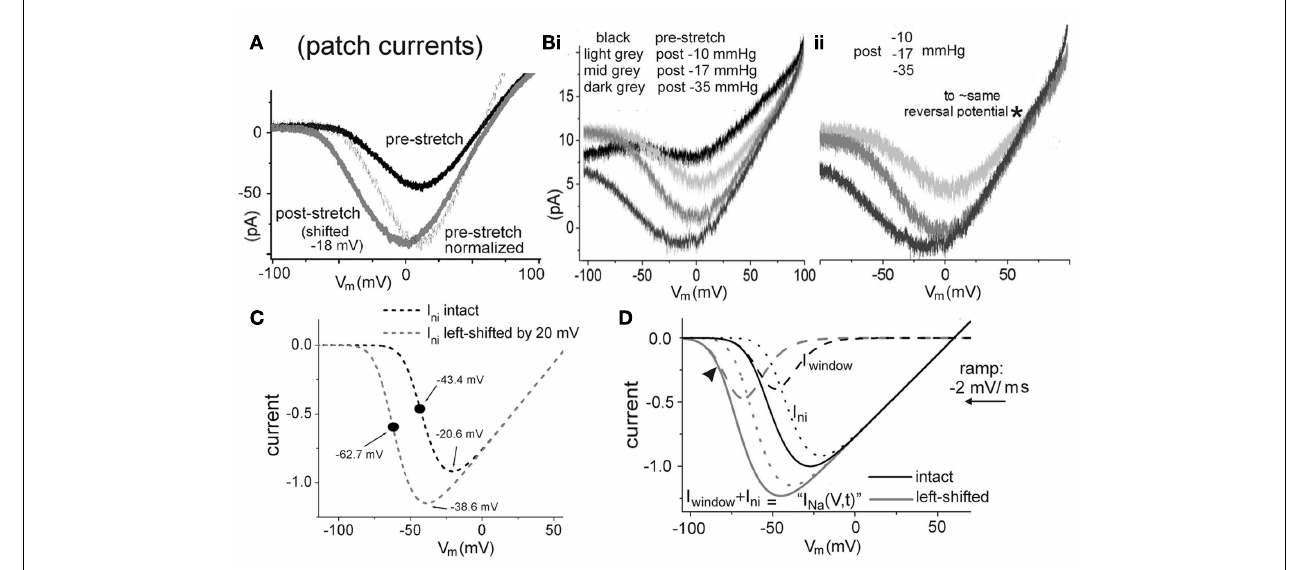
FIGURE 4 | Hyperpolarizing ramps. (A) Recombinant Nav1.6, oocyte patch, I Na elicited by hyperpolarizing ramps from + 100 to − 100mV, − 2mV/ms, before and after membrane damage. (Bi) . Similar data set before stretch then after increasingly strong ∼ 20s bouts of pipette aspiration (conditions as in (A) ; further explanation in text). (Bii) Damaged-membrane traces, y -axis adjusted, as described in text. (C) Simulated I Na-ni ( V , t ) for “intact” and 20mV left-shifted non-inactivating HH-type Nav channels (ramps: − 2mV/ms).The I Na